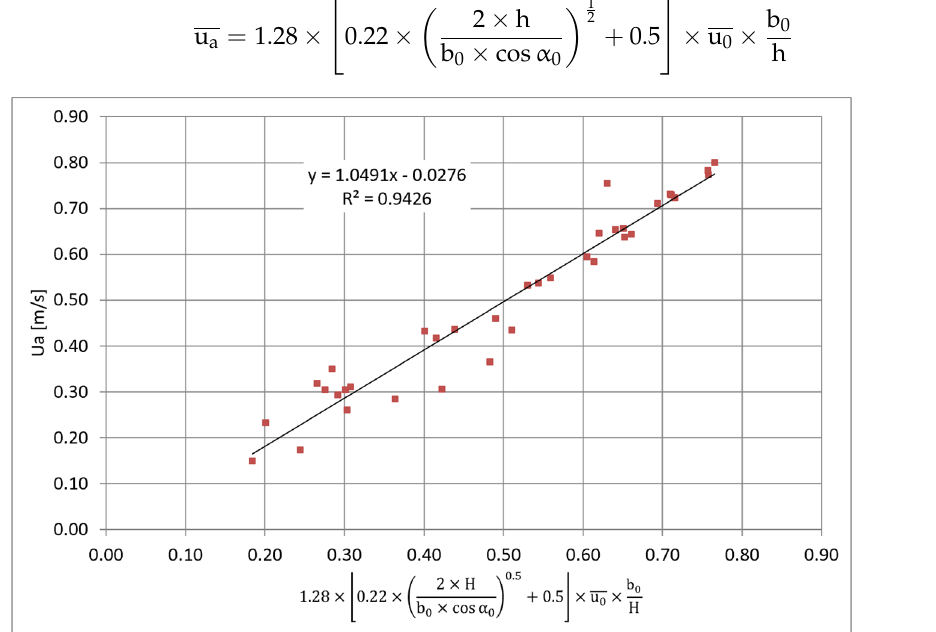
Figure 14. Least square fit for the test results with Re > 3820.